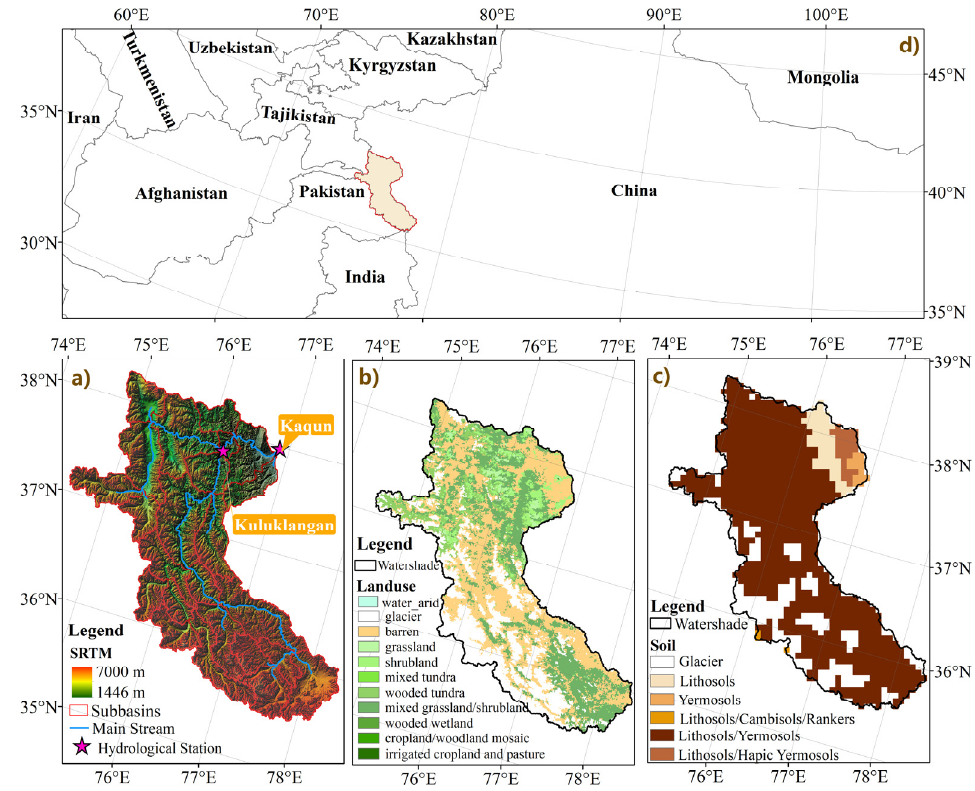
Figure 2. Input data and location of the Upper Yarkant River (UYR) basin, ( a ) SRTM and hydrological stations, ( b ) Land use, ( c ) Soils, ( d ) Location of the UYR basin.